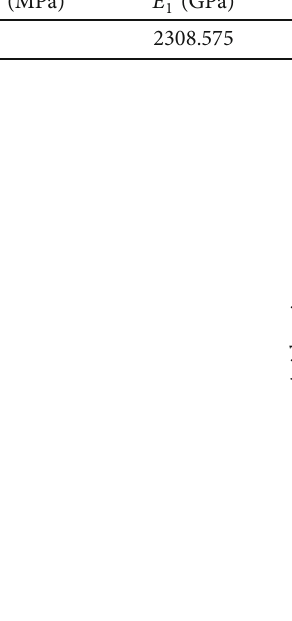
Figure 10: Comparison between calculated displacement and actual